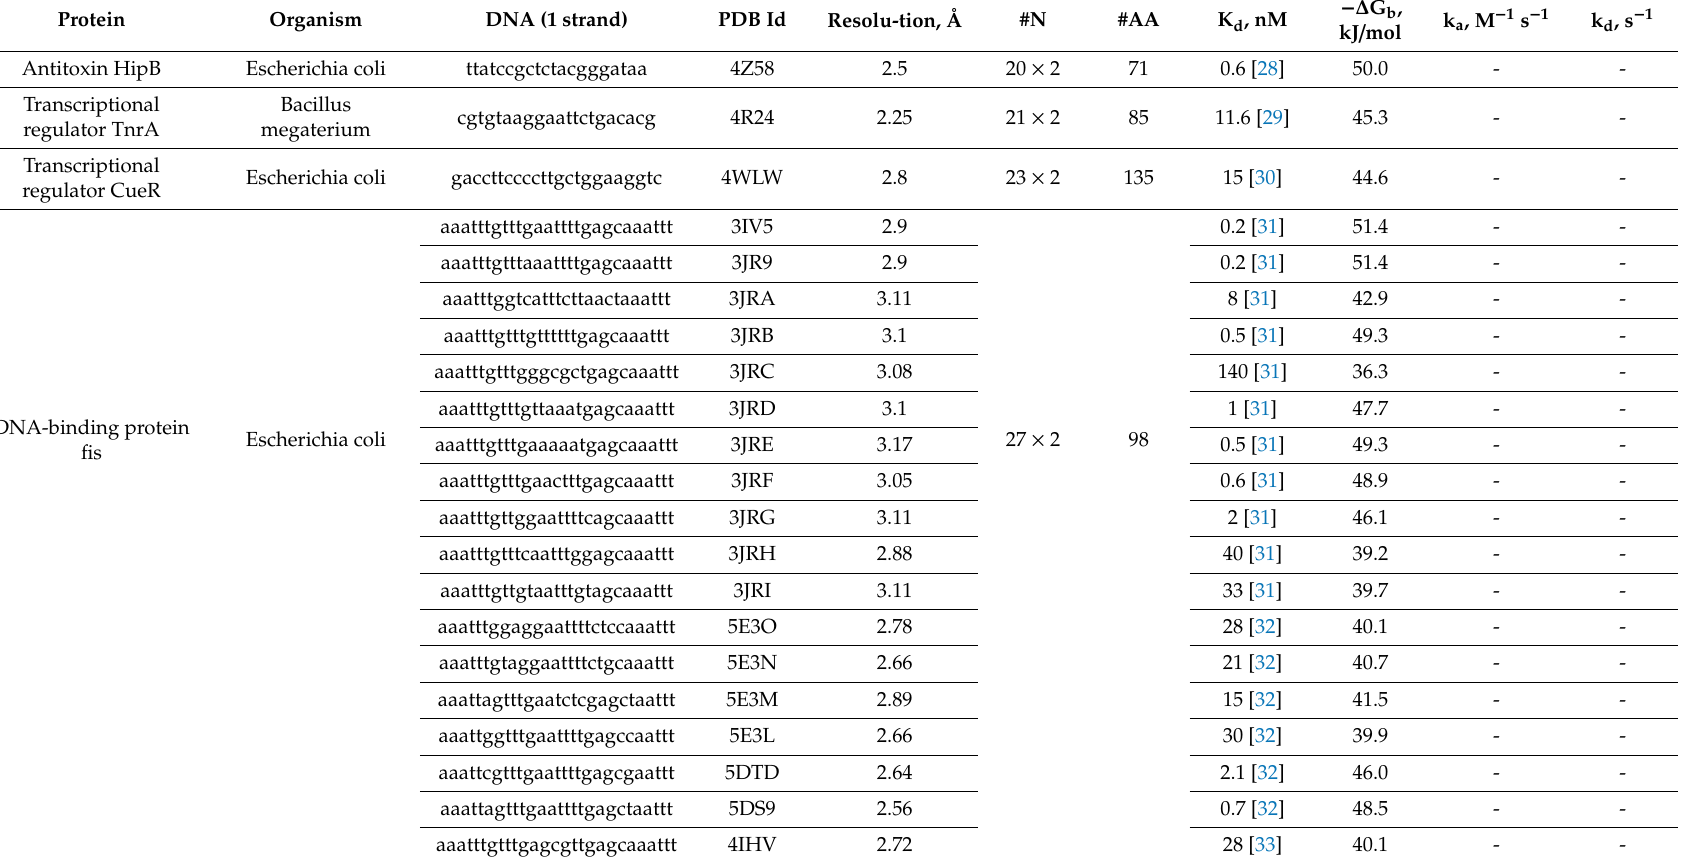
Table 4. A list of complexes of HTH-type proteins with DNA duplexes and their parameters, including protein name, host organism of protein, DNA sequence, accession number in Protein data bank (PDB Id), resolution of the structure, numbers of nucleotides (#N) and amino acid (#AA) residues, an apparent